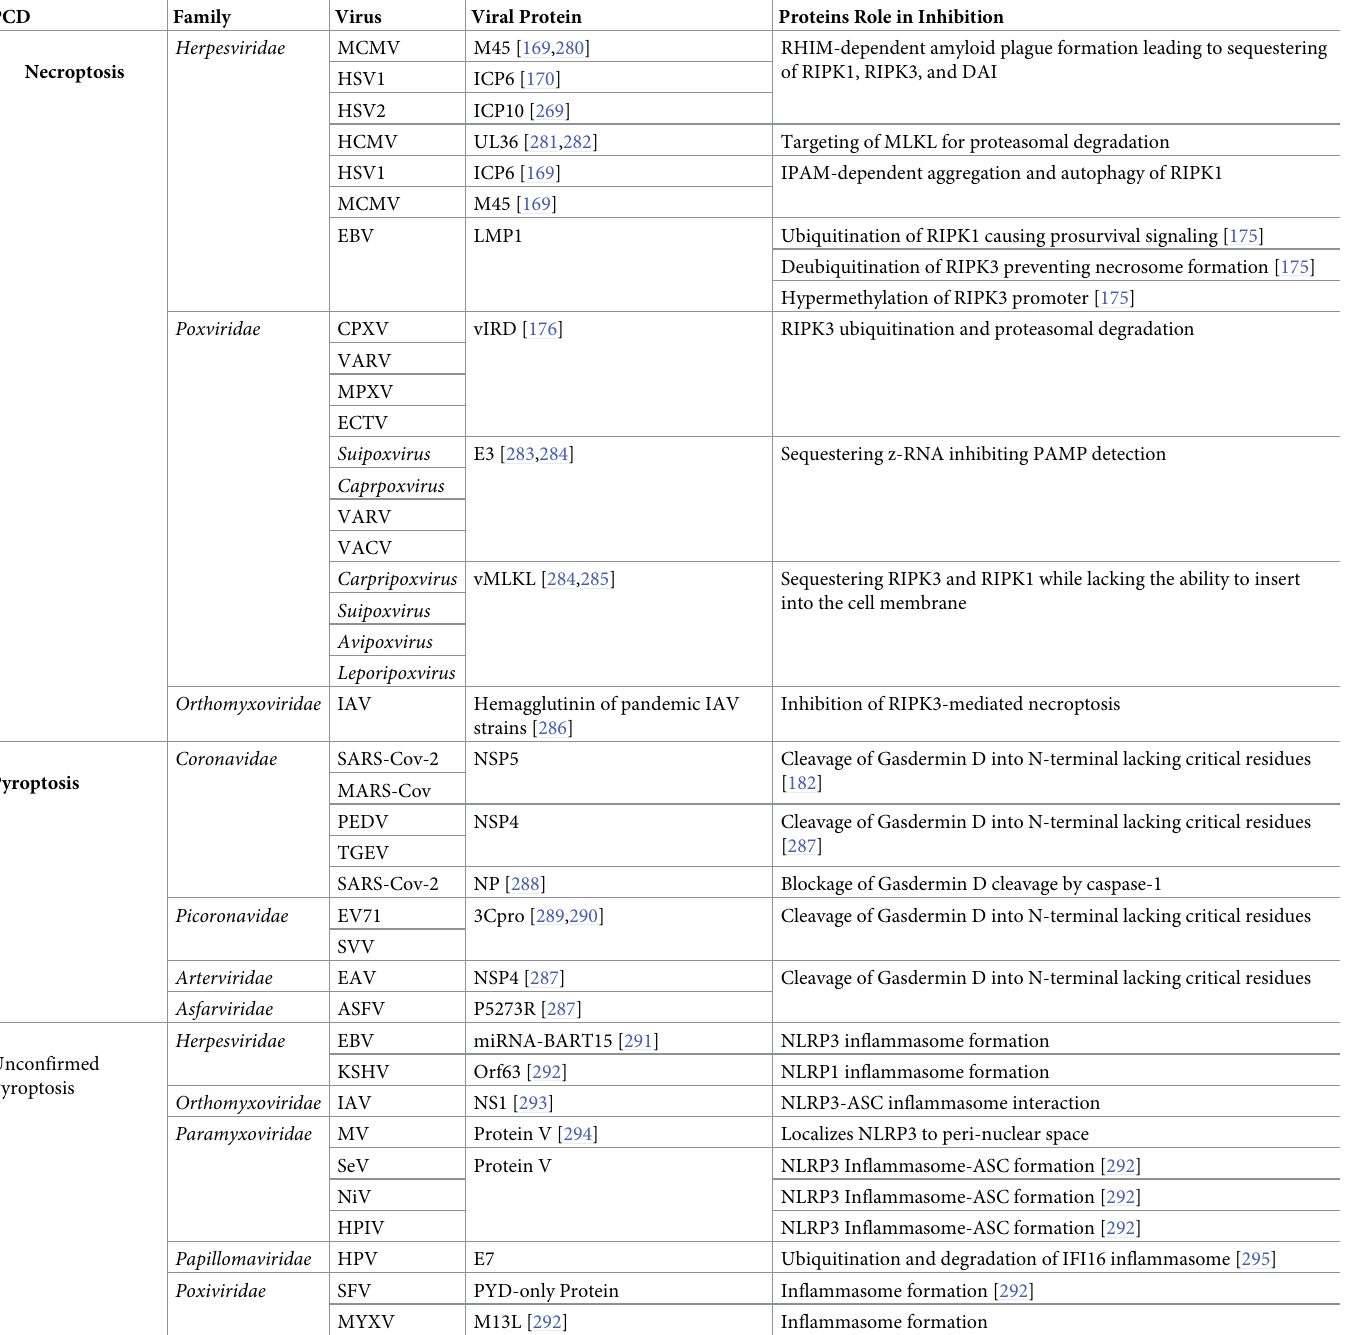
Table 2. Mechanisms of necroptosis and pyroptosis inhibition during virus